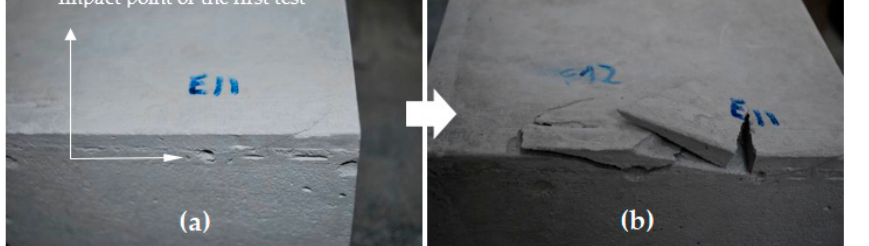
Table 4. Summary of the results of the test of the affected zone. (The precision of the measures is of the order of 0.5 ° for θ and 0.1 cm for H C . Besides, the precision of the scanner 3D is 5 mm).